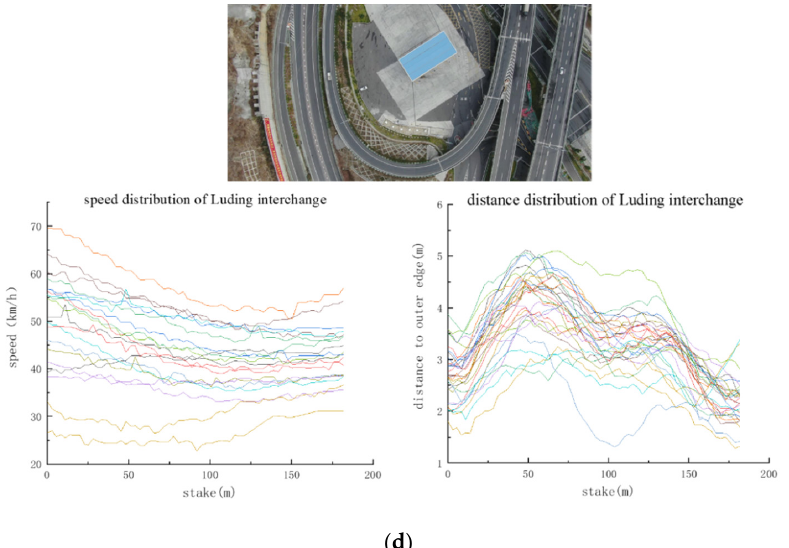
Figure 15. Data of collected road sections: trajectory and speed data of ( a ) main line of Baomao Expressway; ( b ) Tianquan interchange; ( c ) Duogong interchange ramp; ( d ) Luding interchange ramp.